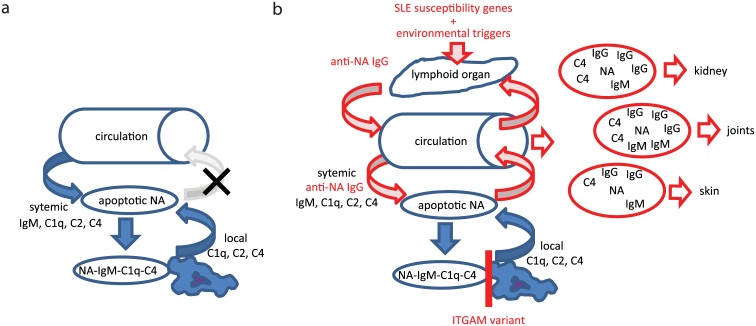
Scheme for the role of complement in the pathogenesis of anti-dsDNA IgG positive SLE.a. Apoptotic DNA is normally quickly opsonized by systemic IgM, C1q and early complement activation products C4 and C2, locally produced opsonins also helping removal. This opsonized debris is swiftly removed by tissue macrophages, thus the level of debris is controlled in the circulation and other organs are protected from its pathological accumulation. b. Inefficient local and systemic removal by dysfunctional CR3 encoded by ITGAM on tissue and sinusoidal macrophages results in increased levels of opsonized debris in the circulation. Circulating immune complexes reach lymphoid organs and trigger production of antigen specific antibodies. In the presence of other SLE susceptibility genes and environmental triggers high avidity DNA specific IgG develops. Upon reaching the circulation this IgG enhances complement consumption by apoptotic DNA and triggers FcgammaR mediated inflammation in tissues where immune complexes are deposited. Relative IgG, IgM and C4 content of immune complexes may influence tissue deposition preference.